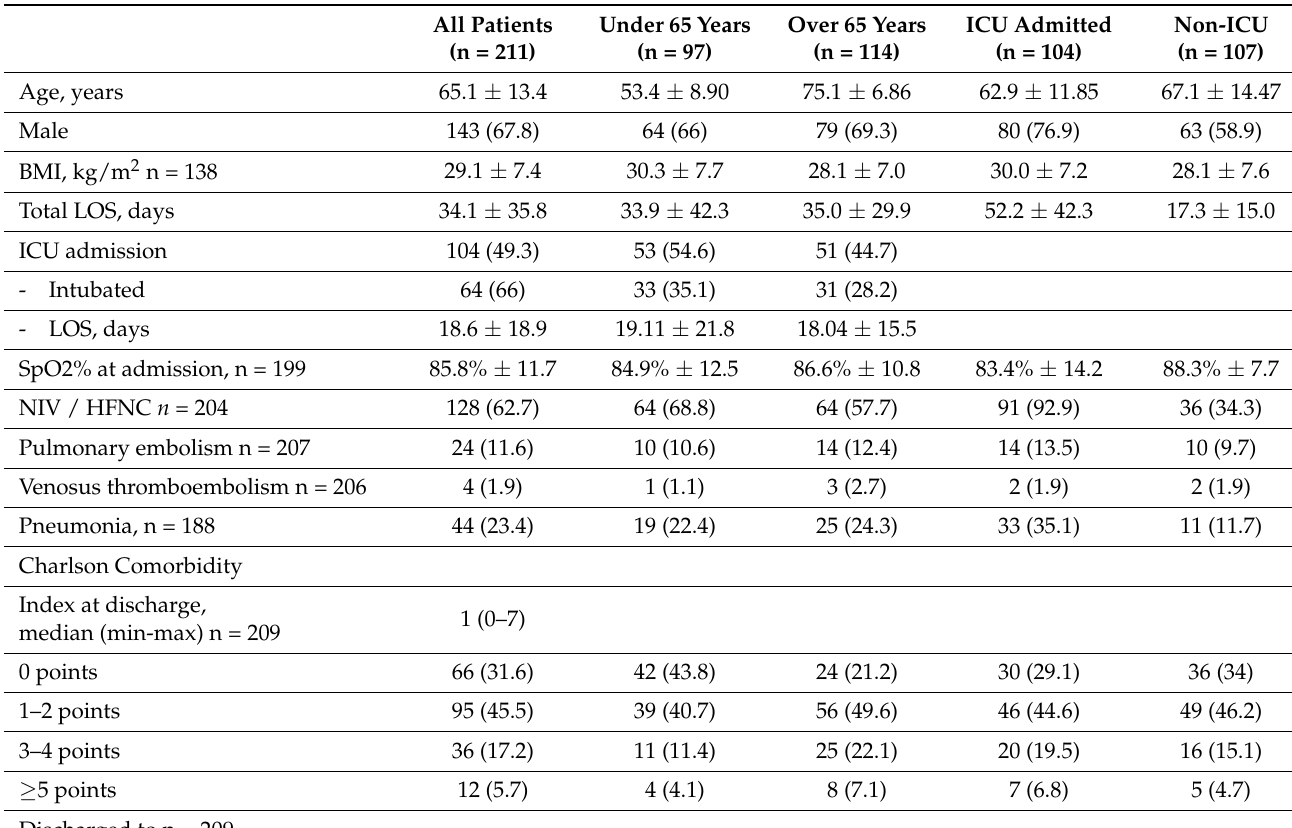
Table 1. Patient